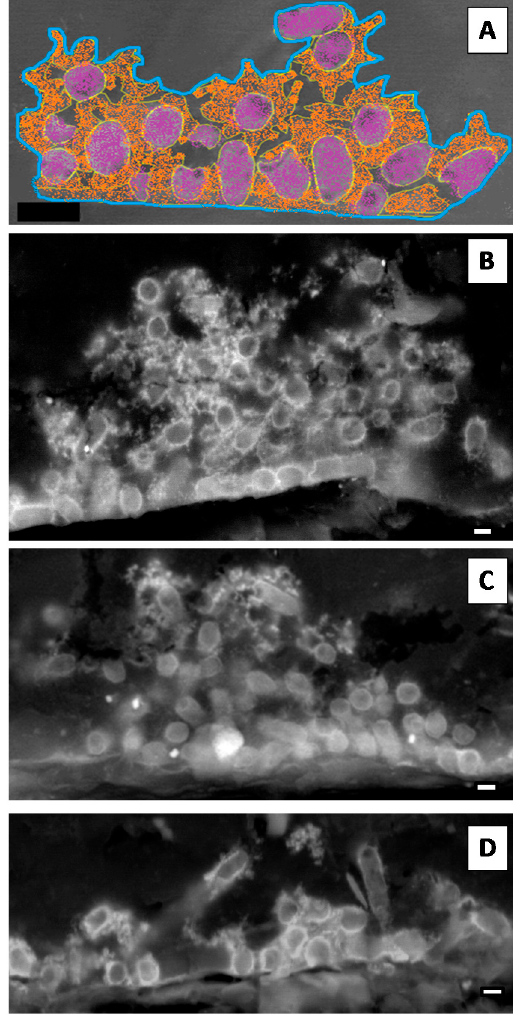
Figure 2. K. pneumoniae biofilms assembled on silicone. The relative areas occupied within biofilms by its major components (bacteria and extracellular polymeric matrix—EPS) were determined using ImageJ software. ( A ) The total biofilm area was delimited (blue line) as well as the areas occupied by bacteria (purple) and EPS (orange) as schematically shown. Representative micrographs of 4 h old: ( B ) Kp703; ( C ) Kp45; and ( D ) Kp2948 are shown (scale bars = 1 μ m).